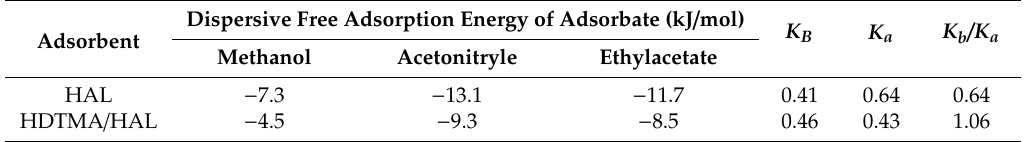
Table 3. Surface properties of the HAL and HDTMA / HAL samples.